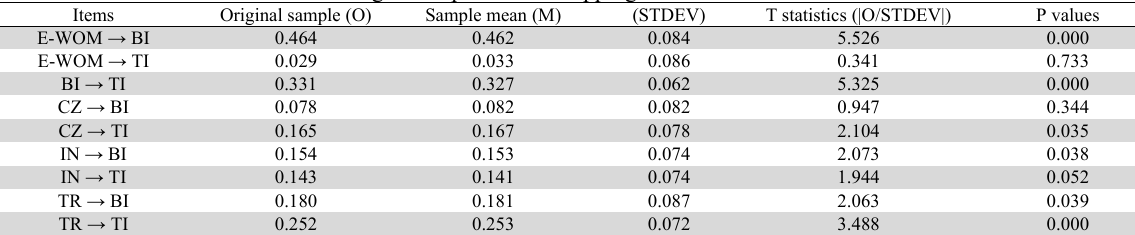
Final Path Coefficients Assessment Using a Complete Bootstrapping Routine